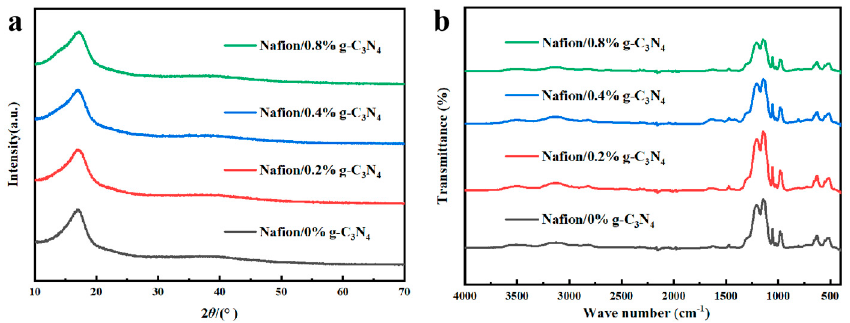
Figure 6. ( a ) XRD and ( b ) FT − IR profiles of the Nafion/g-C 3 N 4 modified membranes.